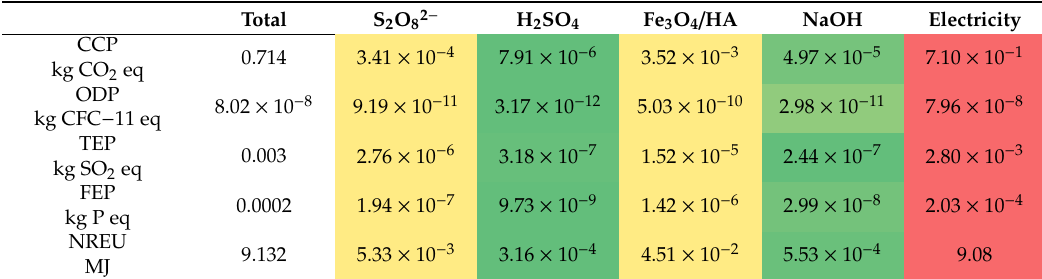
Table 2. Impact at the midpoint level for the degradation process of 90% of 20 µ M BPA in 1 L of water in the presence of Fe 3 O 4 / HA (100 mg / L) and persulfate (1 mM) at pH 3.